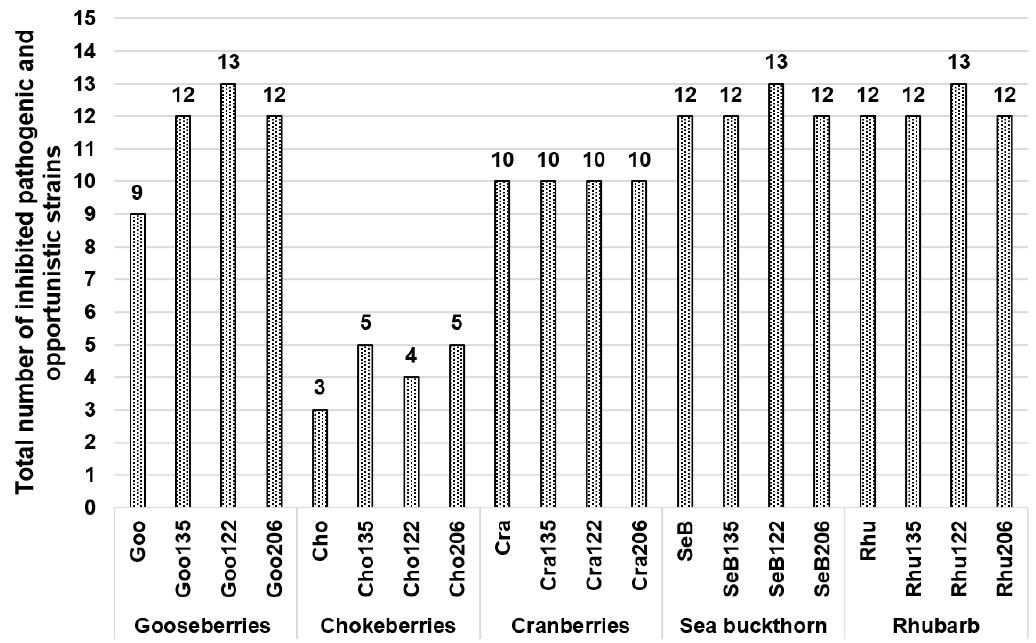
Figure 2. Total number of inhibited pathogenic and opportunistic strains, inhibited by the tested berries / vegetables (gooseberries, chokeberries, cranberries, sea buckthorn, rhubarb) and their combinations with milk permeate fermented with Lactobacillu plantarum LUHS135 , Lactobacillu plantarum LUHS122, and Lactobacillu faraginis LUHS206. Goo—gooseberries; Cho—chokeberries;